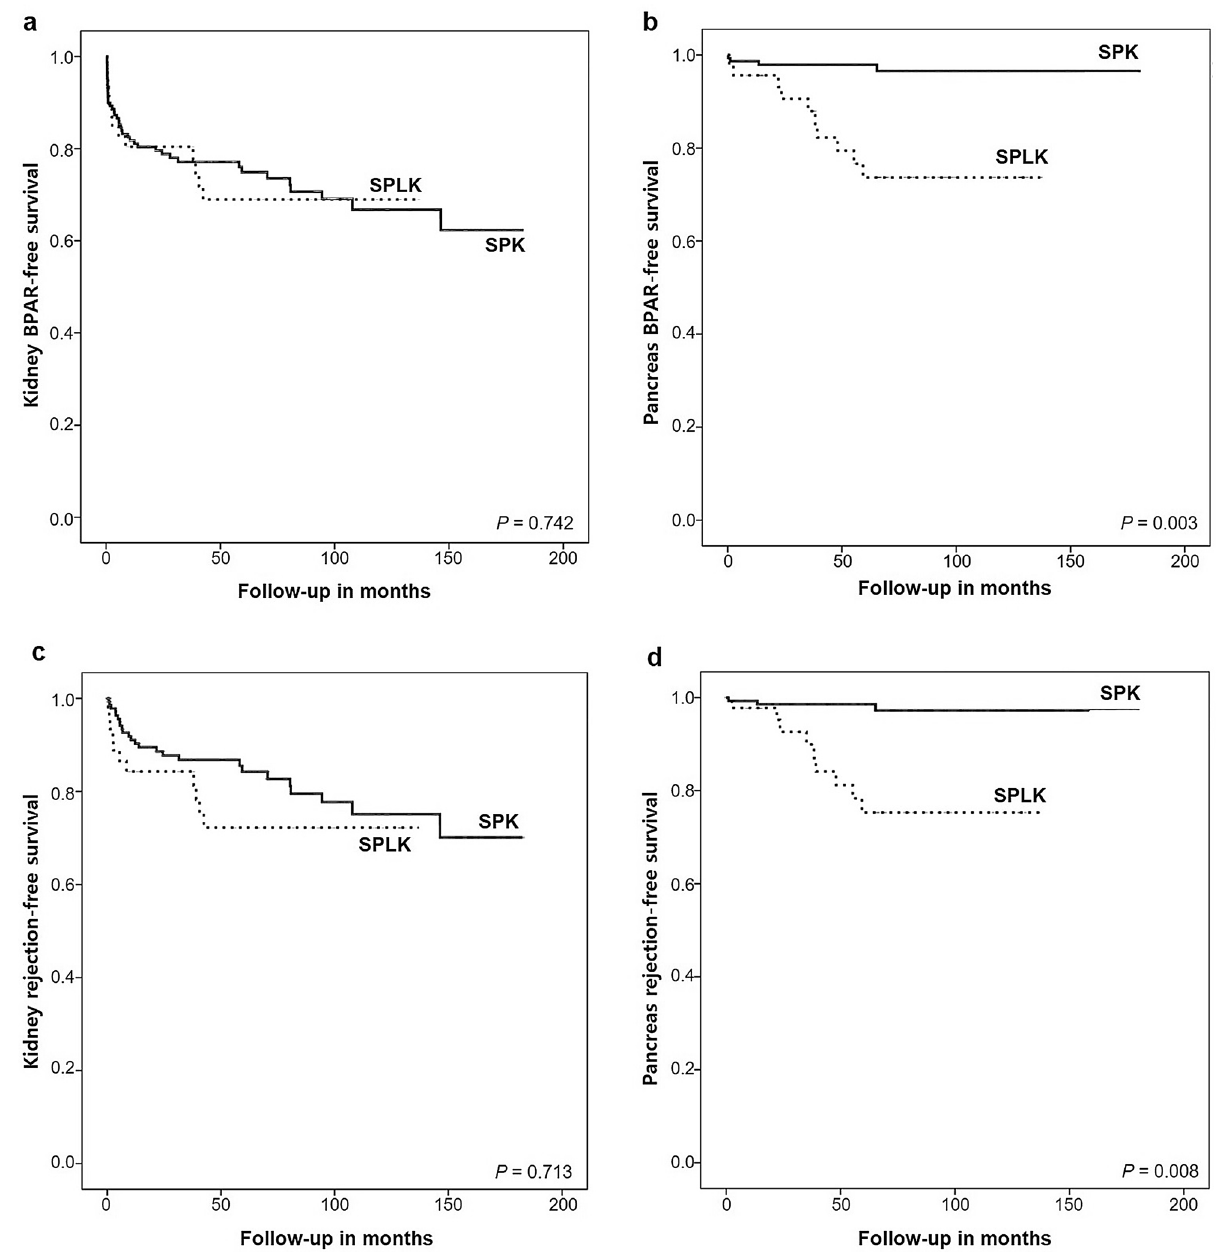
(SPK) and pancreas and living-kidney transplantation (SPLK)